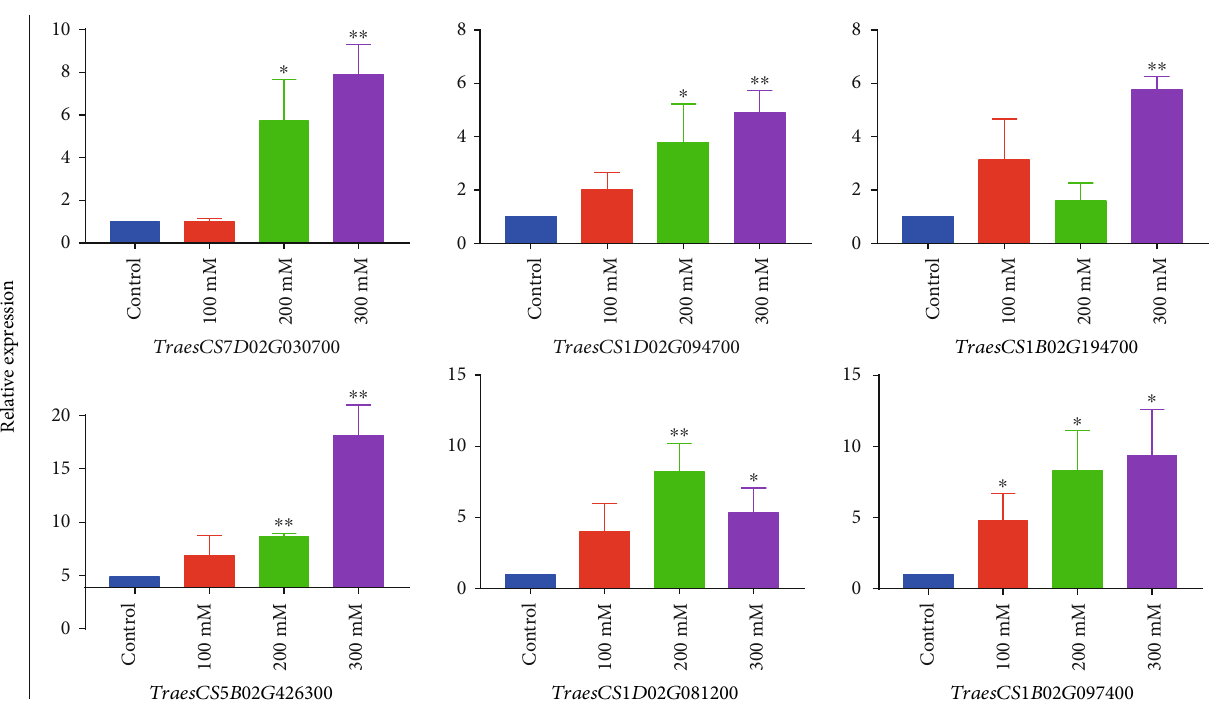
Figure 6: Relative expression of the selected glutathione S-transferase genes, as analyzed by quantitative real-time PCR. Di ff erent salt concentrations are represented by corresponding colors (blue (control), red (100mM), green (200mM), and purple (300mM)). The error bars represent the standard deviation (S.D.) of the means of three independent replicates. Compared to the control group, statistically signi fi cant di ff erences referenced to ∗ P < 0 : 05 and ∗∗ P < 0 : 01 by Student ’ s t